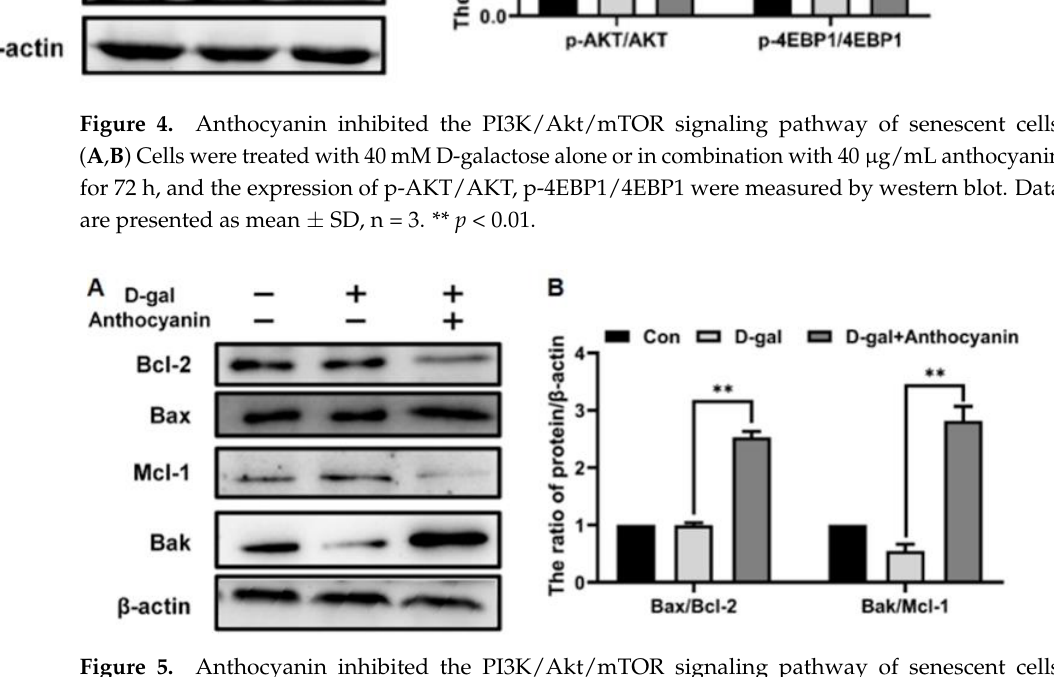
Figure 5. Anthocyanin inhibited the PI3K/Akt/mTOR signaling pathway of senescent cells. ( A , B ) Cells were treated with 40 mM D-galactose alone or in combination with 80 μg/mL anthocyanin for 72 h. The expression of Bcl-2 family proteins was measured using western blot. Data are presented as mean ± SD, n = 3. ** p < 0.01.